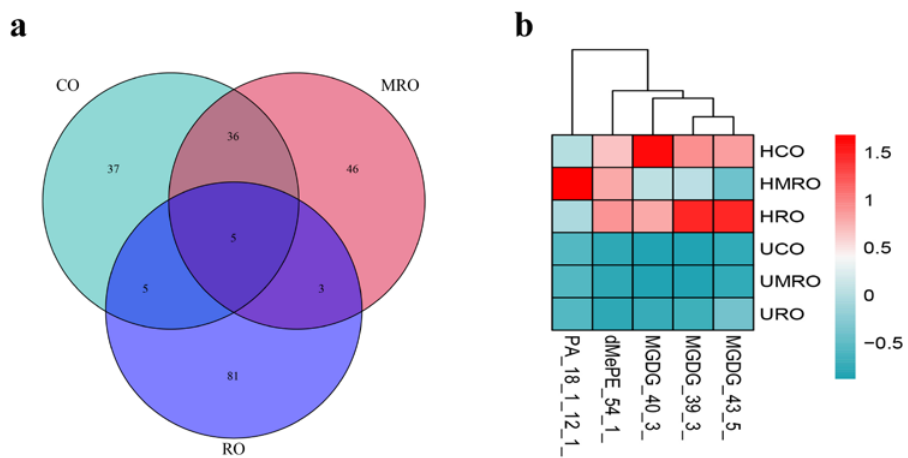
Figure 14. The Venn diagram and heat map of three kinds of camellia oil. ( a ) The Venn diagram; ( b ) The heat map.